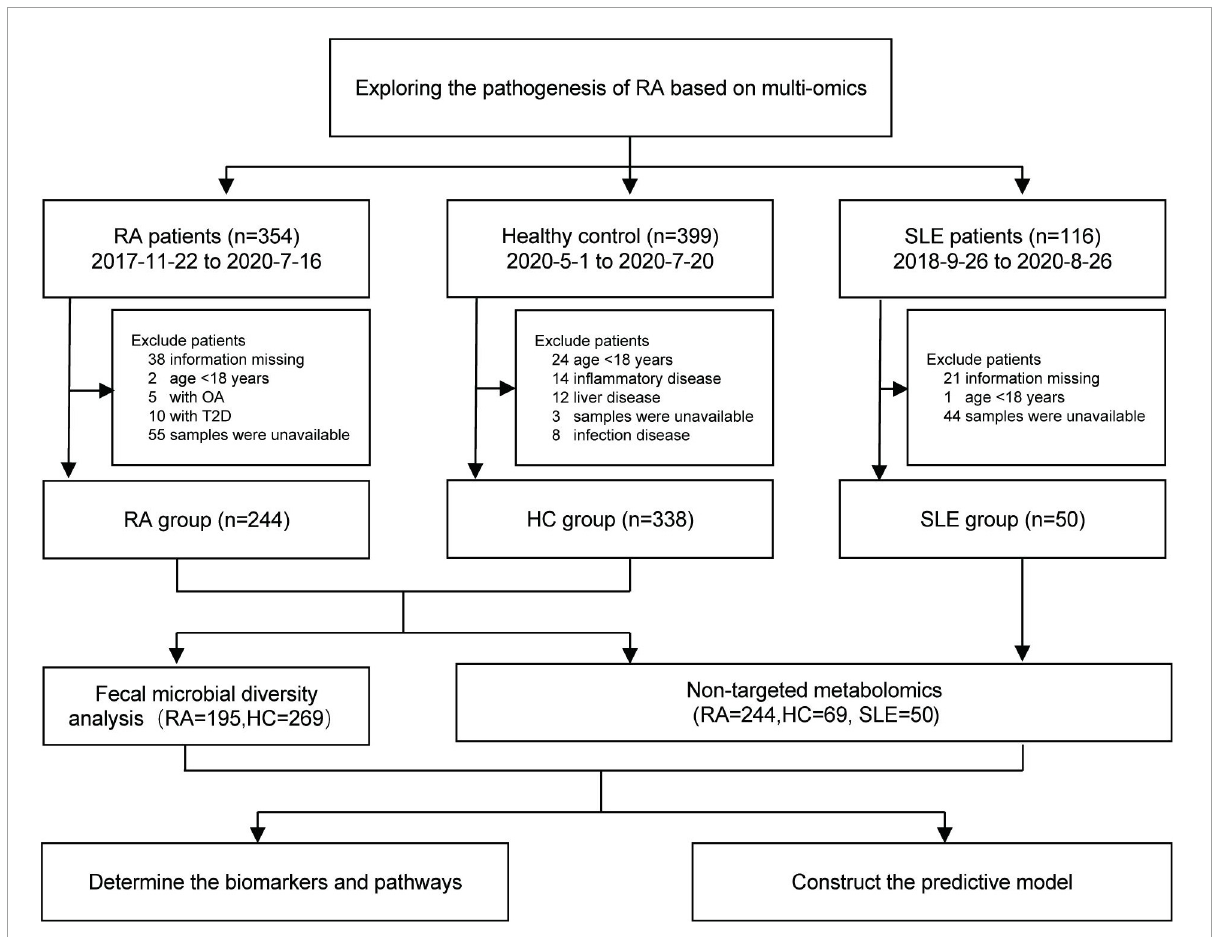
FIGURE1 The flowchart of the study. RA, Rheumatoid arthritis; HC, healthy control; SLE, systemic lupus erythematosus.